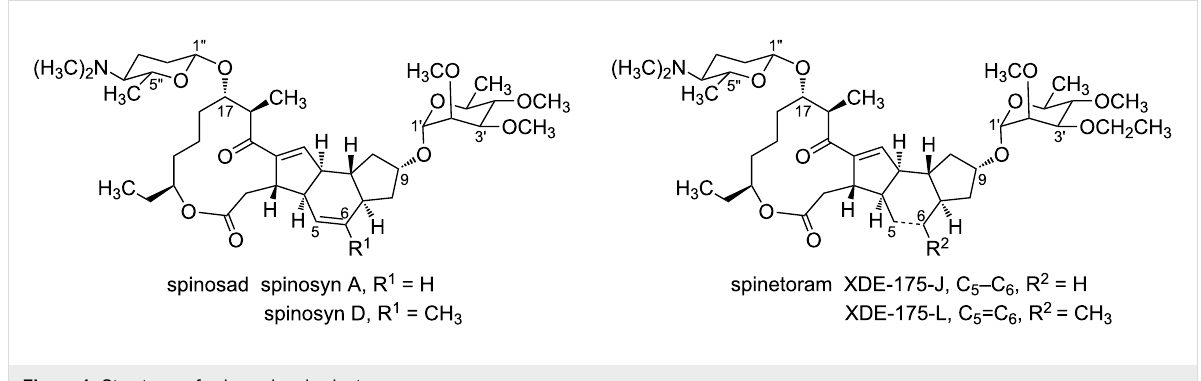
Figure 1: Structures of spinosad and